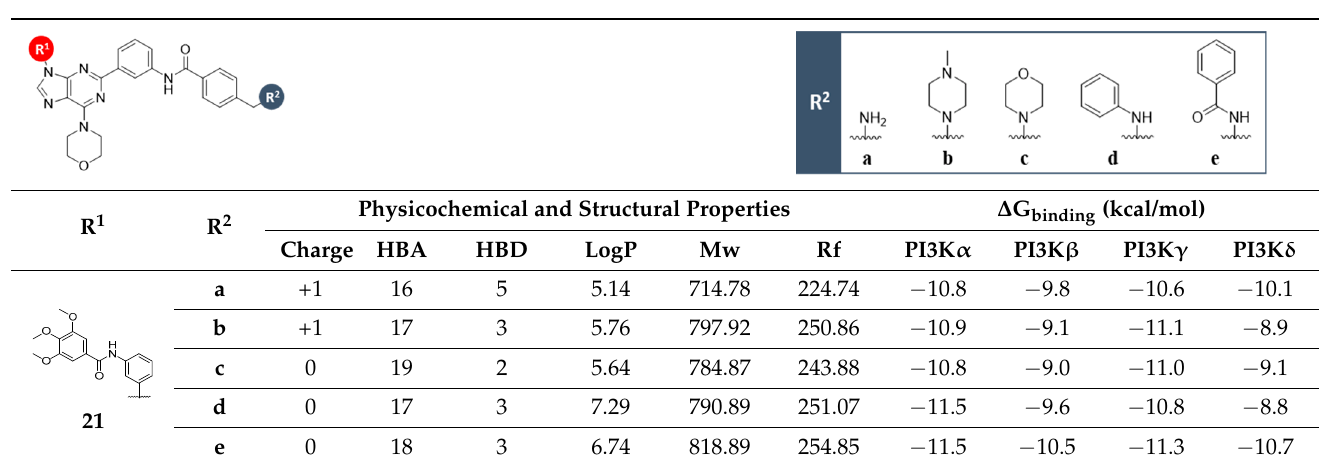
Table 1. Description of the physicochemical and structural properties of the ligands under study and